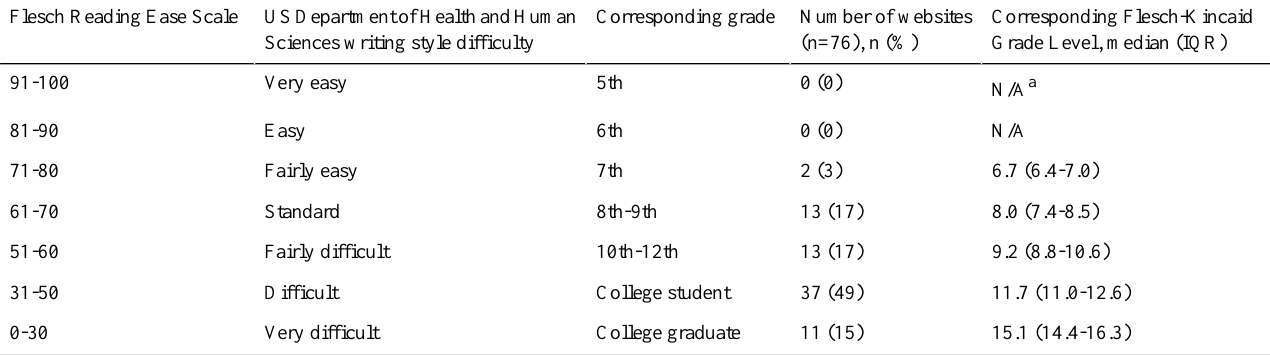
Table 3. Percentage of websites per each Flesch Reading Ease Scale category and corresponding Flesch-Kincaid Grade Level.